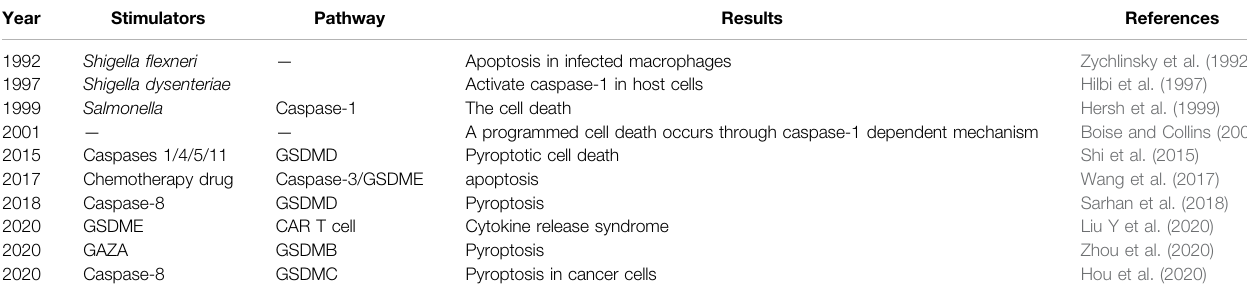
TABLE 1 | The history of the discovery of pyroptosis and its related research